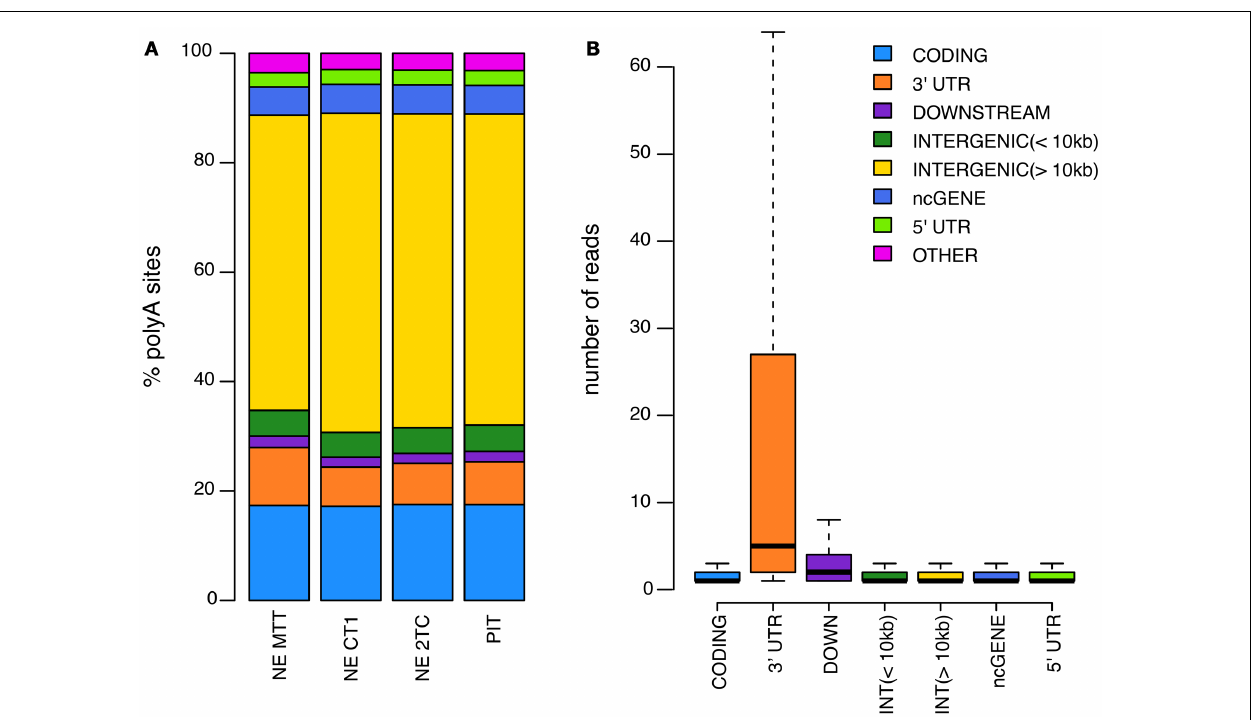
FIGURE 3 | (A) Distribution of identified polyA sites across the genome for each of the samples analyzed. (B) Average number of reads per polyA site in different genomic